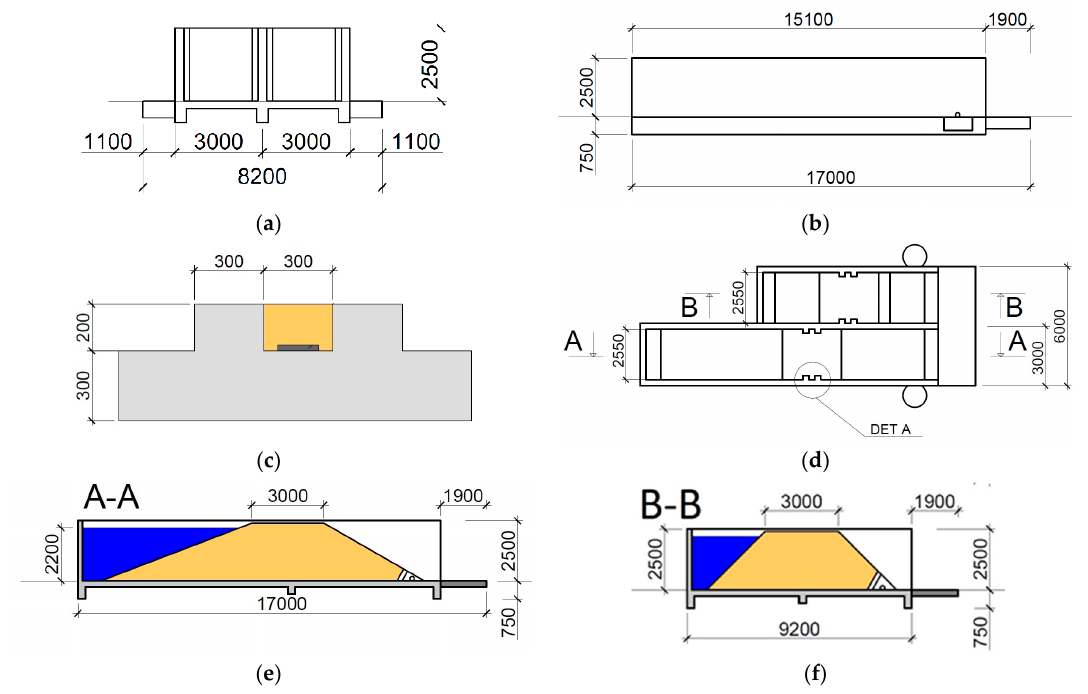
Figure 1. The figure illustrates the physical model constructed at the Czech Technical University in Prague—Underground Research Centre